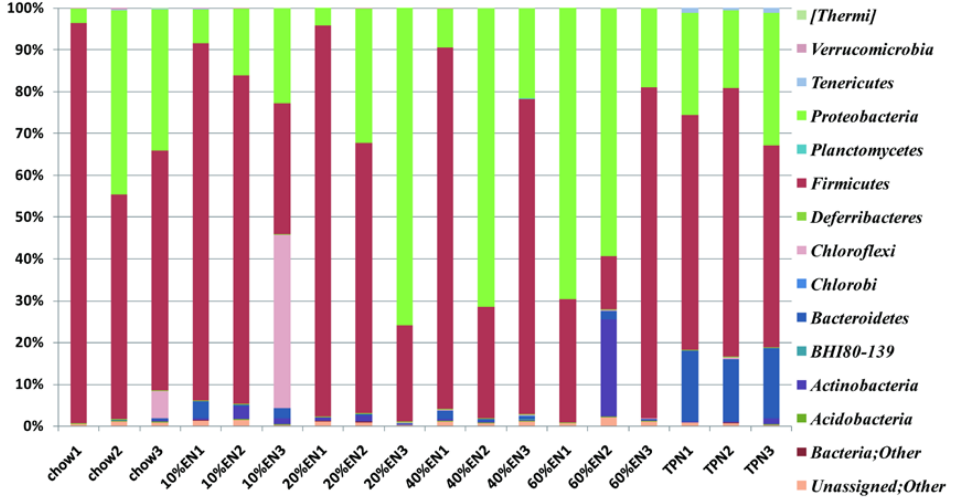
Figure 6. Pyrosequencing analysis of ileal wash samples at the phylum level. EN: enteral nutrition; TPN: total parenteral nutrition.